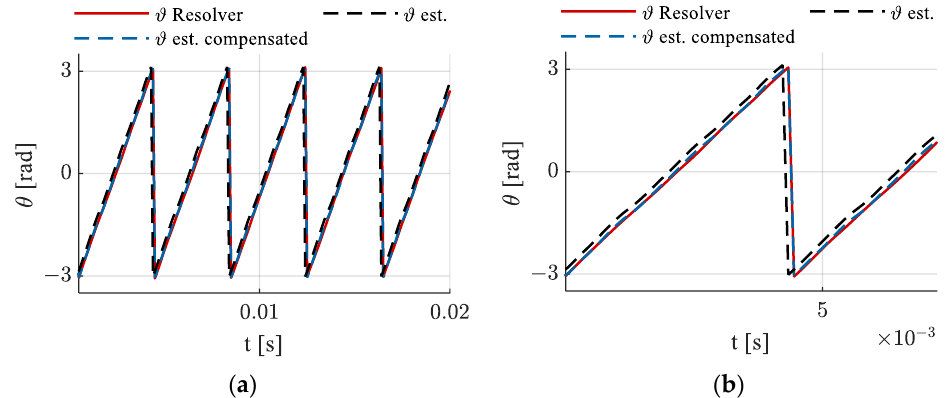
Figure 20. Electrical rotor position: ( a ) load steady state of the emergency three-phase operation; ( b ) zoom of the load steady state at the emergency three-phase operation.